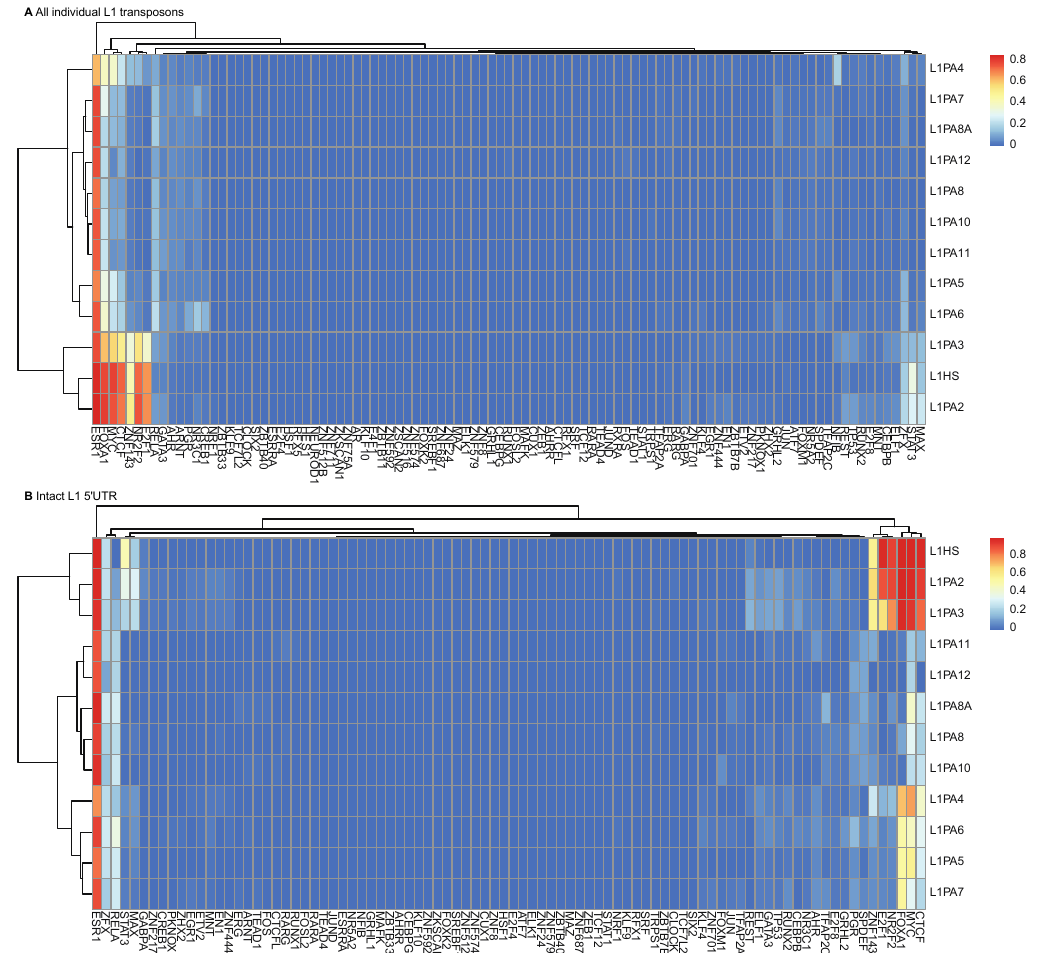
Figure 3. Young primate-specific L1 subfamilies displayed a distinct TF binding profile. TF binding activities in MCF7 cells were identified for ( A ) all individual transposons and ( B ) L1 5 ′ UTRs. Heatmaps show the hierarchical clustering performed on the TF binding frequencies, using pheatmap (clustering_method = “complete”).